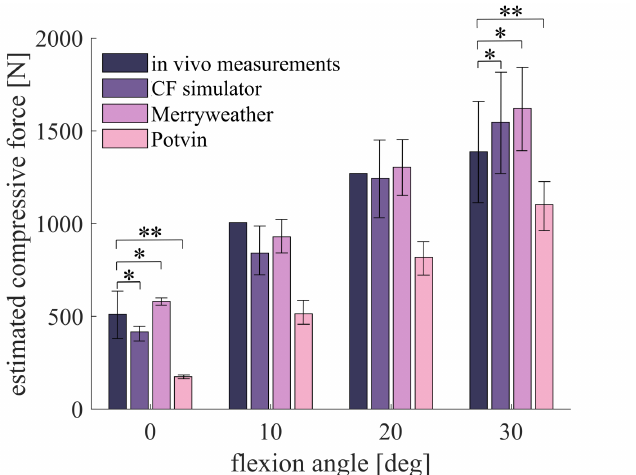
Figure 4. Comparison between different models and invasive measurement under free flexion. The